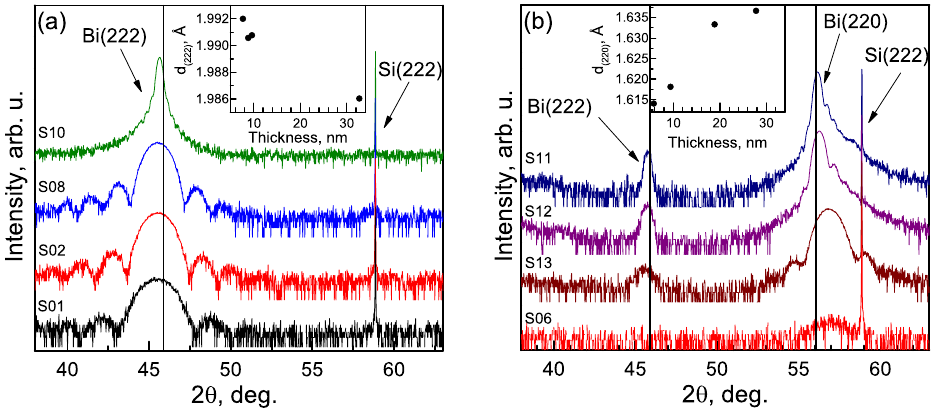
Figure 2. Out-of-plane ω /2 θ curves of β -Bi ( a ) and α -Bi ( b ). The vertical black lines show 2 θ values of Bi (222) and Bi (220) planes calculated for lattice with a = 4.7459 Å and α = 57.237 ◦ . Interplanar spacing dependencies on the layer thickness are shown in the insets. In-plane measurement of β -Bi samples shows the opposite strain to out-of-plane measurements: peaks corresponding to (110) and (112) planes perpendicular to the surface have higher 2 θ values (lower interplanar distance—insets of Figure 3a,b), showing that biaxial compressive strain is perpendicular to growth direction (Figure 3a,b).